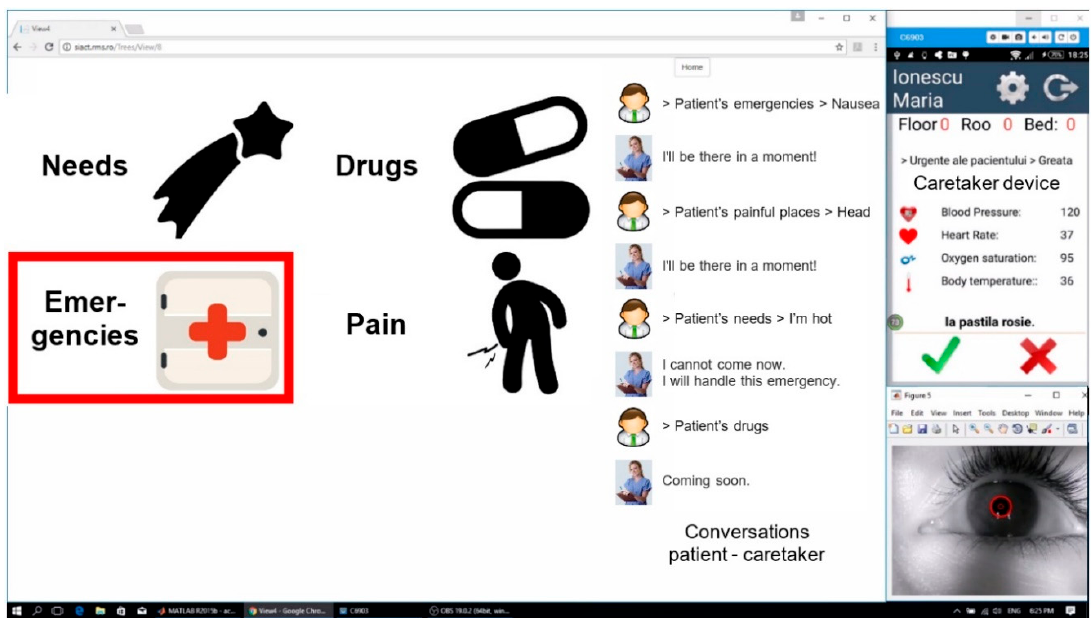
the PDA signals.